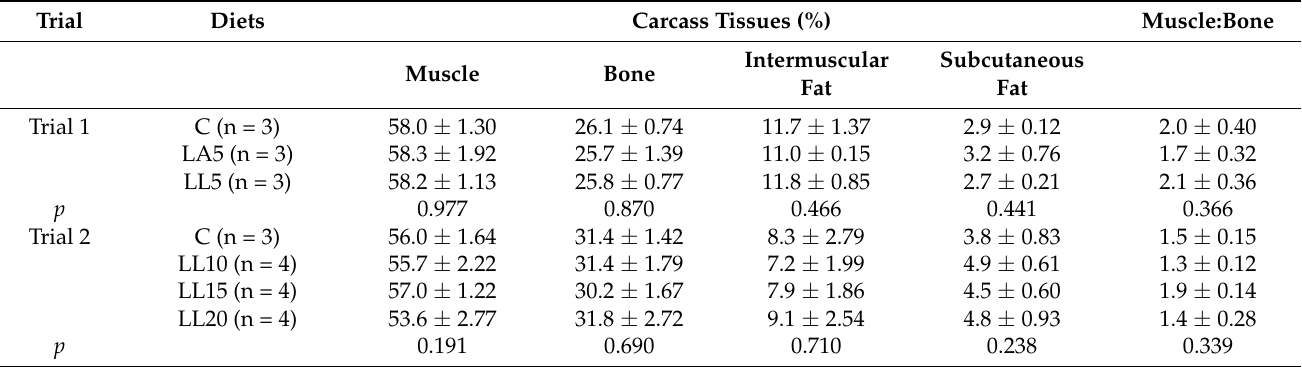
Table 3. Least square means ( ± SE) of carcass composition in tissues (%) and muscle:bone ratio of lambs in trials 1 and 2.